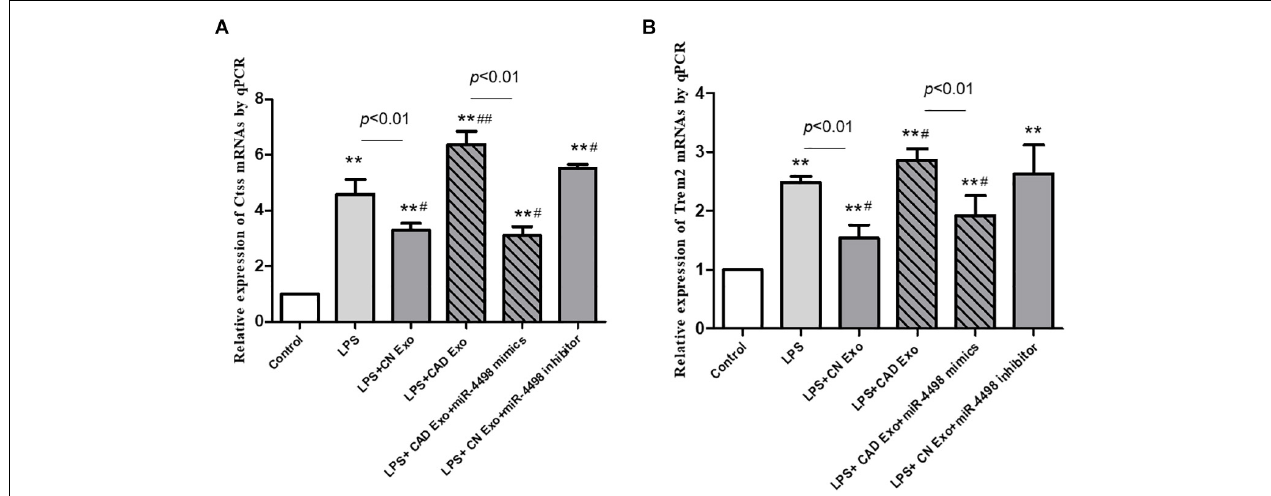
FIGURE 7 | Gene expression of macrophages induced by exosomes from the plasma. The quantitation of mRNAs of Ctss (A) and Trem2 (B) in THP1 cells was detected by RT-qPCR. ** p < 0.01 and * p < 0.05 vs. control, ## p < 0.01 and # p < 0.05 vs. lipopolysaccharide; n =